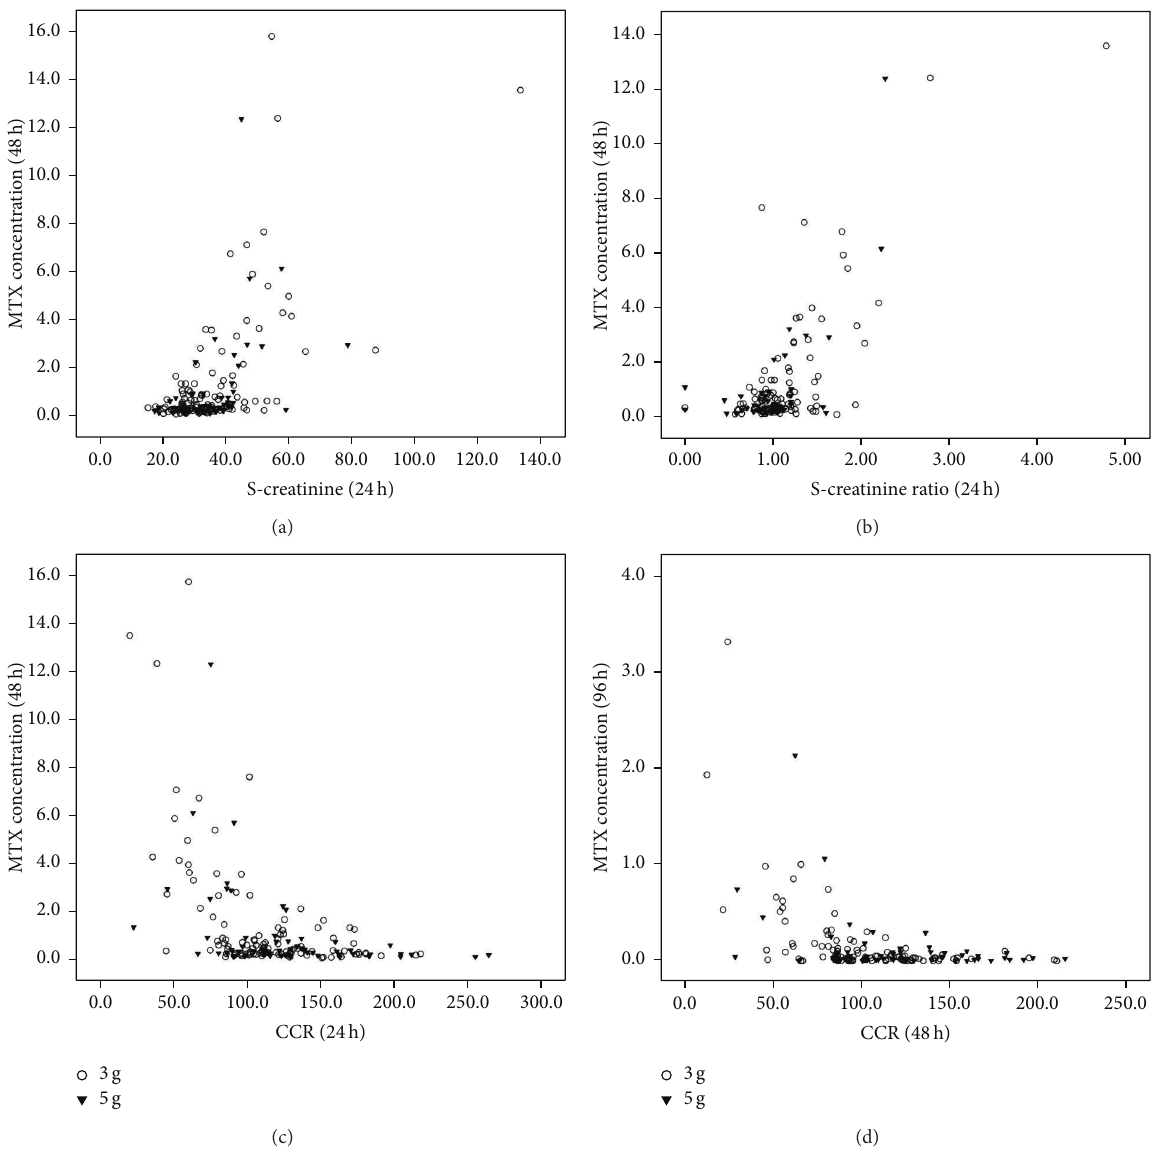
Figure 3: The correlations between serum creatinine concentration ( 𝜇 mol/L), the ratio of serum creatinine level in 24 hours to creatinine level before MTX infusion (S-creatinine ratio), creatinine clearance rate (CCR, mL/min), and serum MTX concentration ( 𝜇 mol/L) in 3g/m 2 (unfilled circle) and 5g/m 2 groups (filled inverted